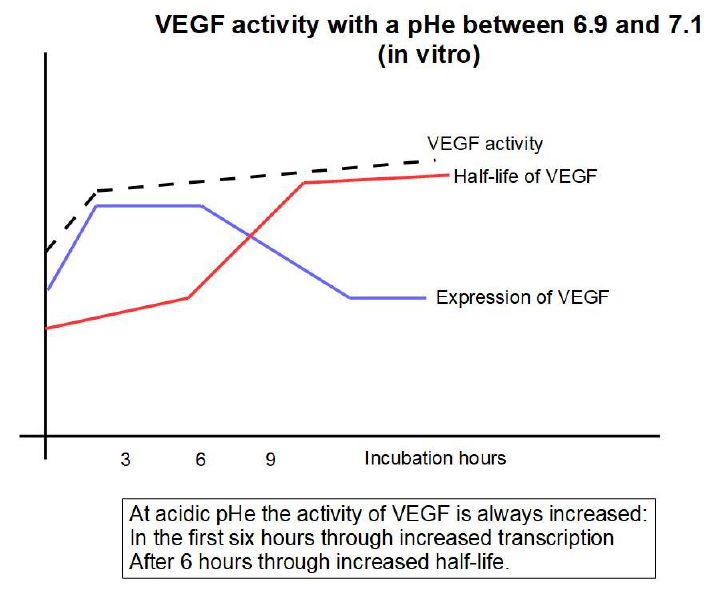
Figure 4. Explanation in the text.